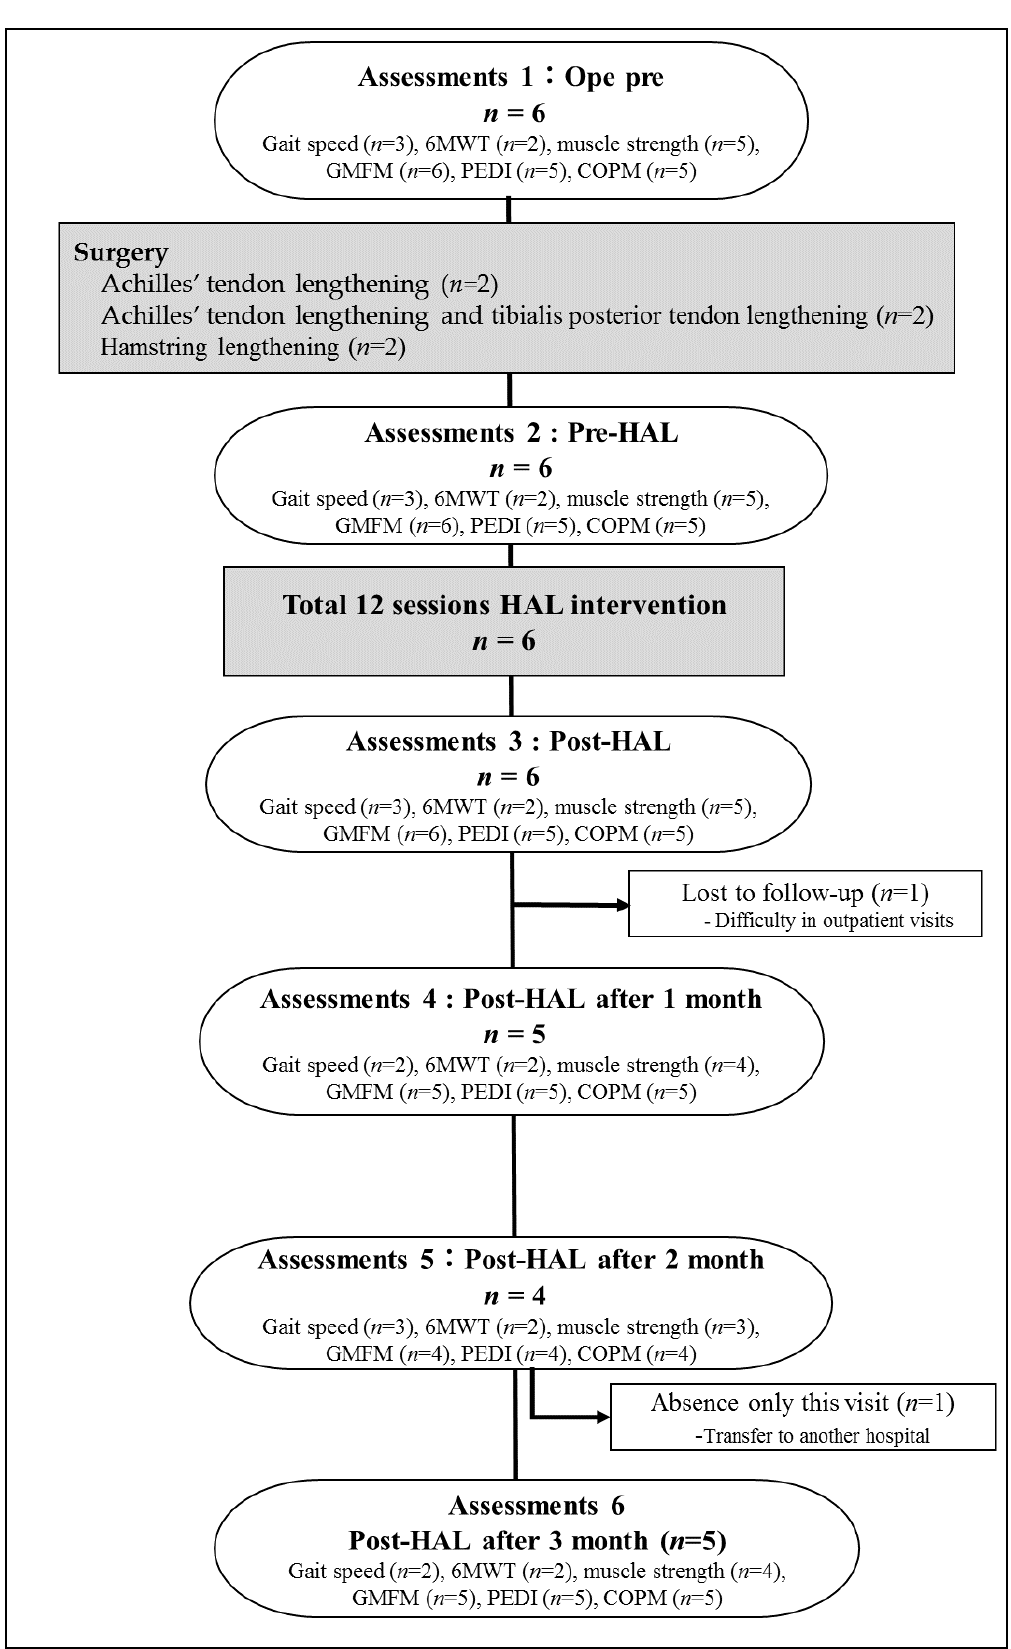
Figure 2. Exercises with the Hybrid Assistive Limb ® (HAL) device.